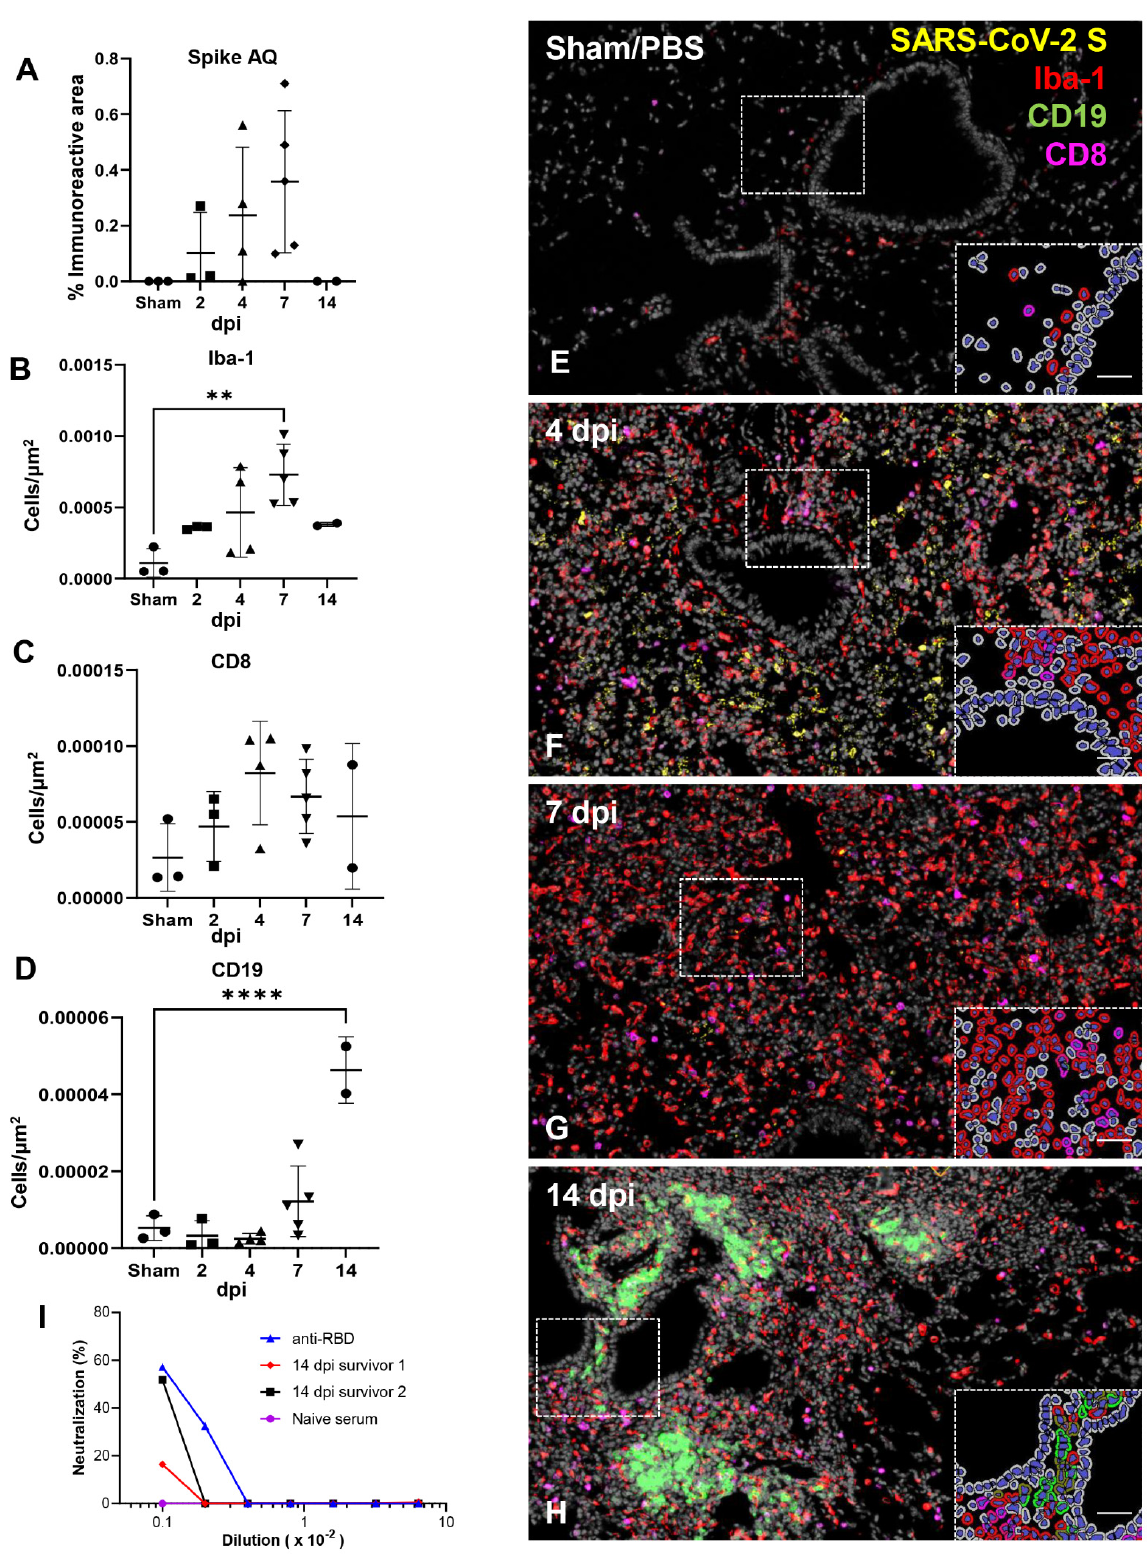
Figure 5. Temporal immunoprofiling of the pulmonary host inflammatory response to SARS-CoV- 2. ( A – H ) Quantification and 4-plex fluorescent IHC targeting SARS-CoV-2 Spike ( A , E – H ), and macrophage Iba-1+ ( B , E – H ), CD8+ ( C , E – H ) and CD19+ cell ( D , E – H ) infiltration in the lung of PBS/Sham inoculated mice and in SARS-CoV-2 inoculated mice (2 dpi (n = 3), 4 dpi (n = 4), 7 dpi (n =